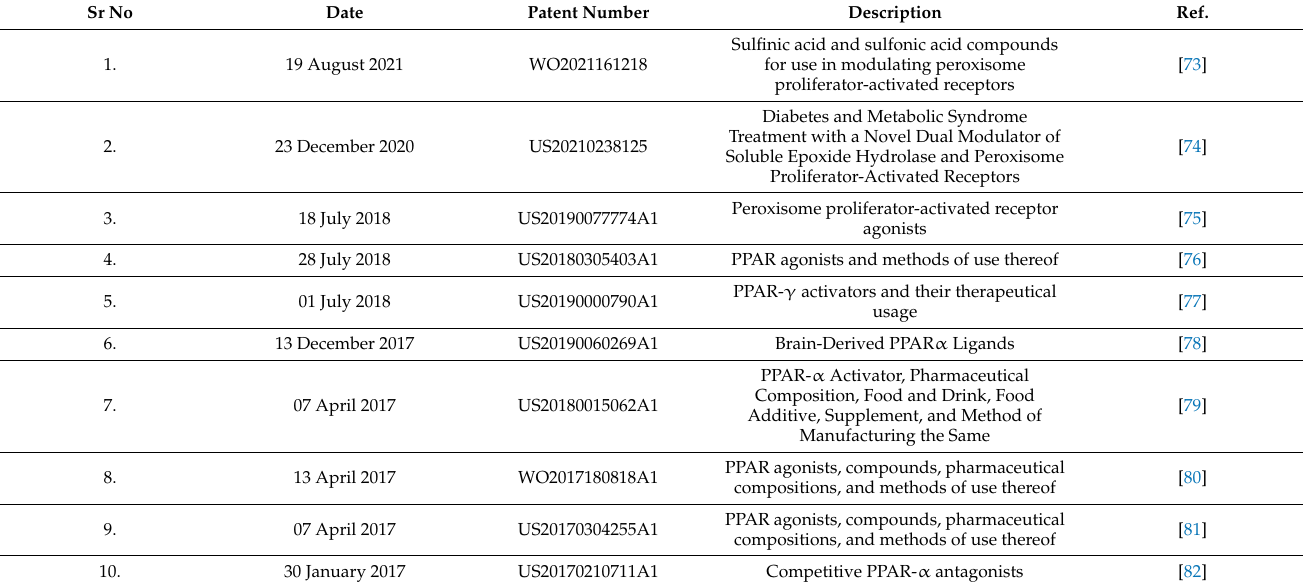
Table 1. Various patents on Peroxisome proliferator-activated receptor.